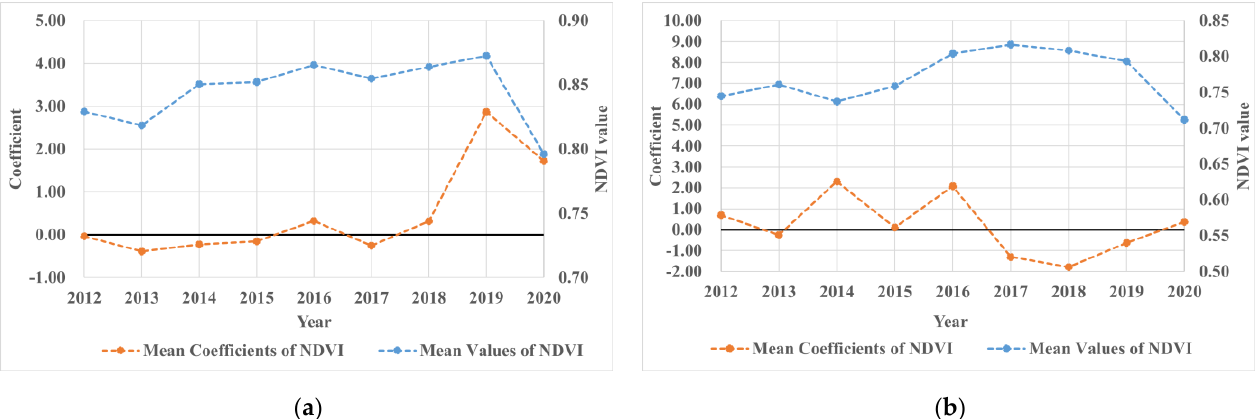
Figure 5. Temporal trends of mean NDVI values and spatial proportion of positive NDVI coefficients.